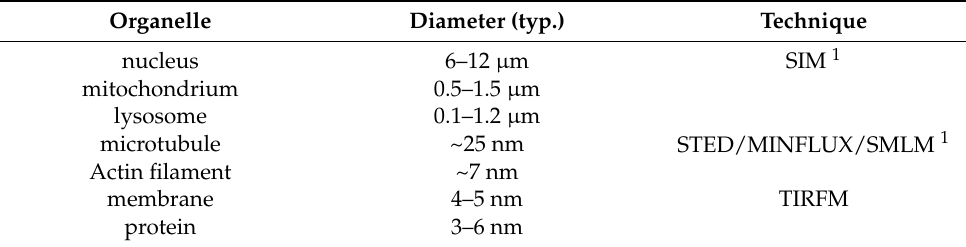
Table 1. Typical size of cell organelles and related super-resolution